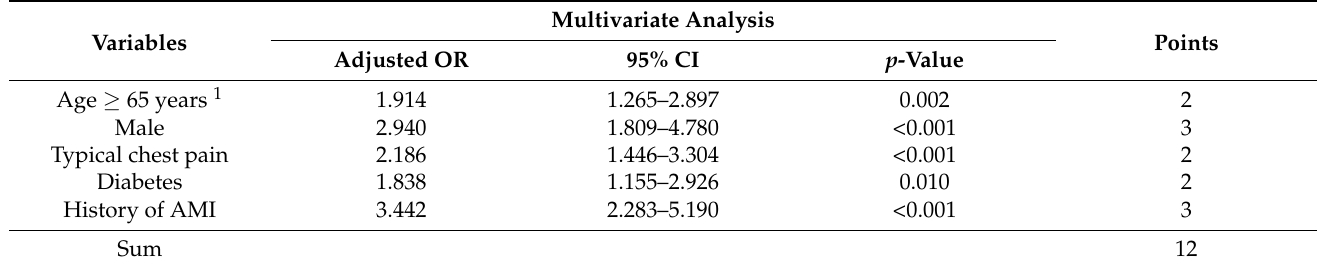
Table 2. Multivariate analysis and new prognostic model for predicting significant stenosis.